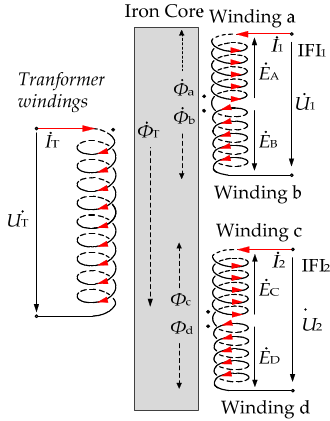
Figure 5. Diagrams of the transformer windings and IFI windings of the HSTT.